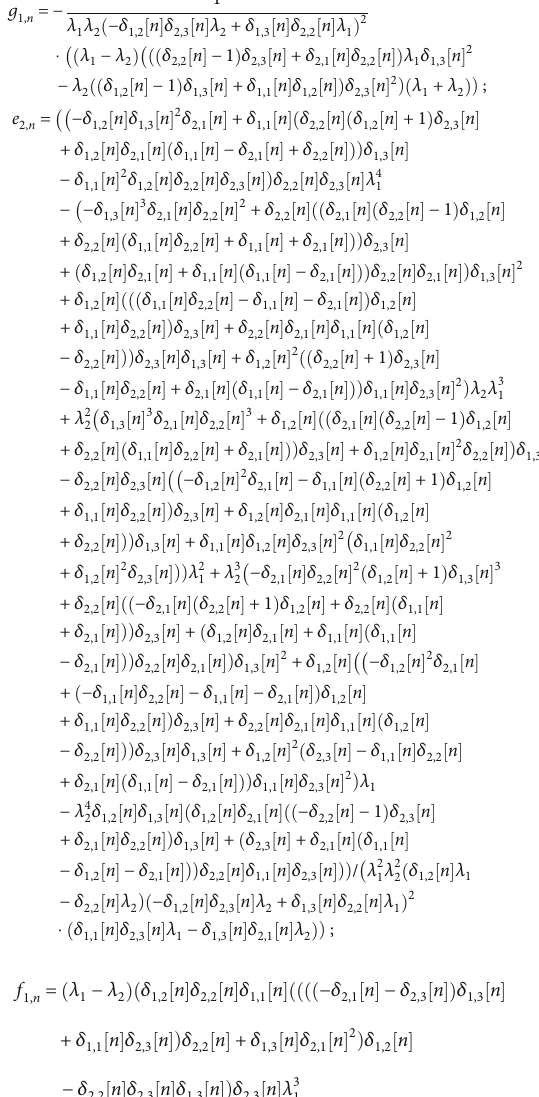
, ~ r , and ~ s with parameters λ 1 = 0 : 3 , λ 2 = 0 : 6 I , κ 1 = n n n